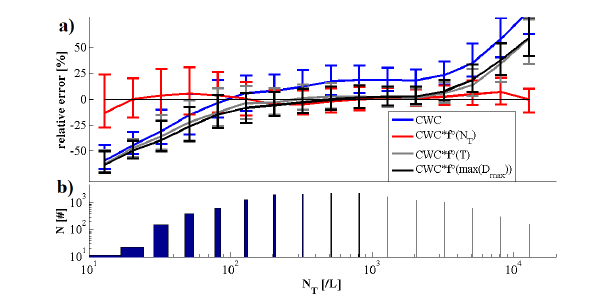
Figure 3. (a) Relative errors of CWC with respect to CWC IKP (as defined in Table 1) as a function of total PSD number concentration N T . The errors are presented with and without the three suggested correction functions for CWC. (b) Number of 5s data points used for the statistics on the y axis as a function of N T